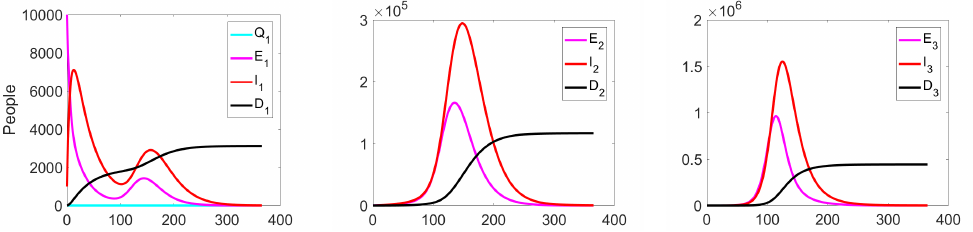
Figure 9. Experiment 1. Number of exposed, infected, and dead in controlled case.